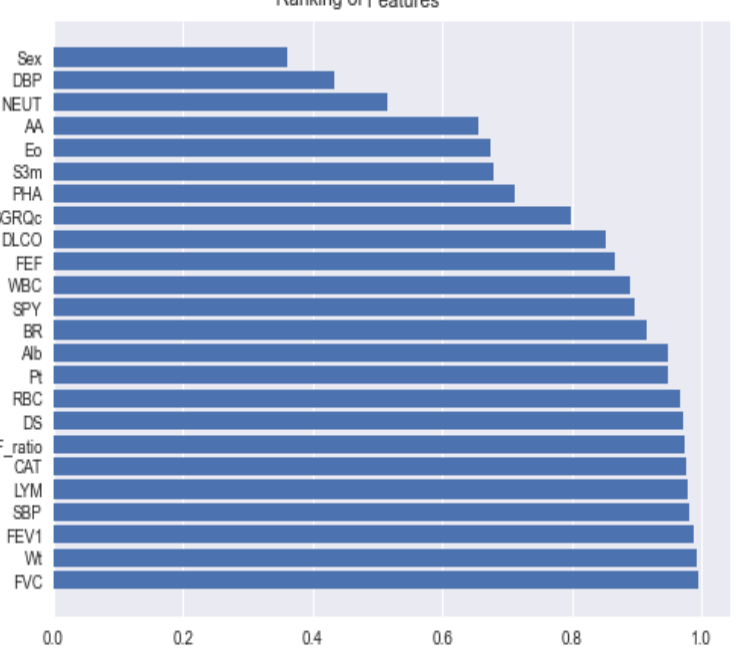
Figure 4. The features importance of the proposed soft voting ensemble classifier. Note that FVC, Wt, FEV1, SBP, LYM, CAT, FF_ratio, DS, RBC, Pt, Alb, BR, SPY, WBC, FEF, DLCO, SGRQc, PHA, S3m, EO, AA, NEUT, and DBP denote forced vital capacity, weight, forced expired volume in one- second prediction, systolic blood pressure, lymphocytes, COPD assessment test score, FEV1/FVC ratio, duration smoke, red blood cells, platelets, albumin, breath result, smoke per year, white blood cell, forced mid-expiratory flow, diffusing capacity of the lung for carbon monoxide, the St. George’s Respiratory Questionnaire, history of asthma, sputum3m, eosinophils, availability of asthma, neutrophil, and diastolic blood pressure,